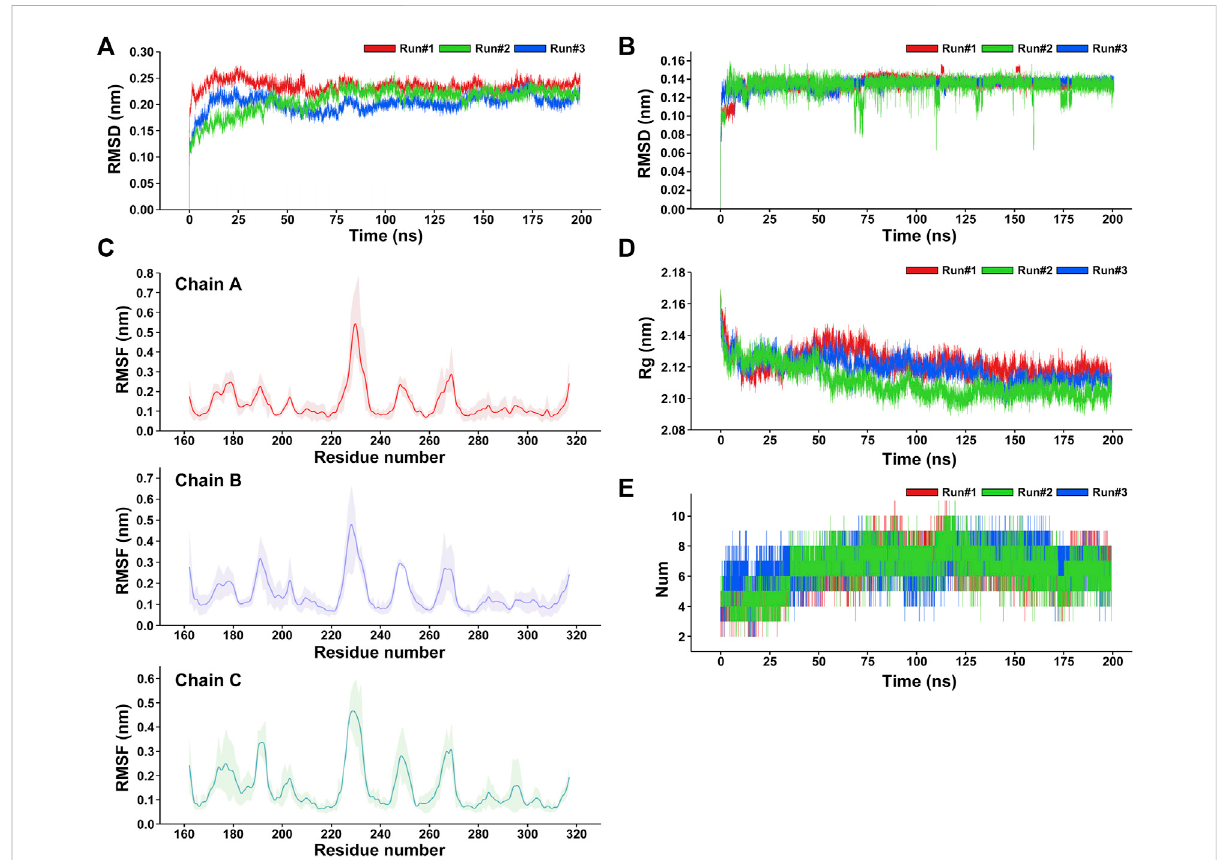
FIGURE 5 Analysis of the three repeated 200-ns molecular dynamics simulations of the RANKL – ZOL docking complex. (A) RMSD plot of the receptor protein RANKL for three repeated MD simulations. (B) RMSD plot of the ligand ZOL for three repeated MD simulations. (C) RMSF plot of the receptor protein RANKL, showing that the residues with strong fl exibility are concentrated in fragments 188 – 195, 225 – 230, 245 – 253, and 265 – 270; and the structuresofresiduesinfragments215 – 222,275 – 315arerelativelystableintheMDsimulation.TheRMSFvaluesarerepresentedasmean±SD, where the average RMSF of each residue for three repeated simulations is shown as a solid line, and the fl uctuation range of the RMSF value of each residue on the curve is shown in light color. (D) Rg plot of the receptor protein RANKL with respect to time (ns) for three repeated MD simulations presenting the comparative compactness. (E) Pro fi le of the dynamics of intermolecular hydrogen bonds within the complex, shows the time distribution of the number of hydrogen bonds between ZOL and RANKL in the MD simulation. During the period 0 – 36 ns, the number of